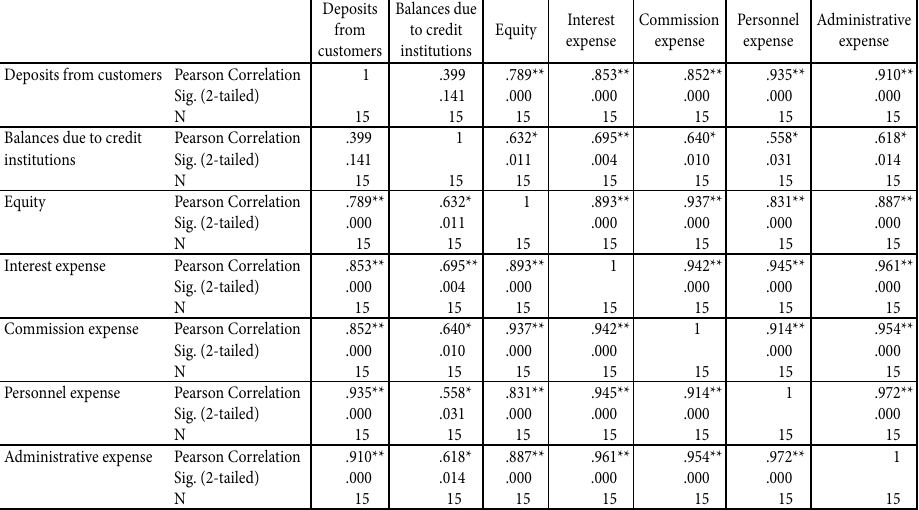
Fig. 1. Results of the correlation analysis for input